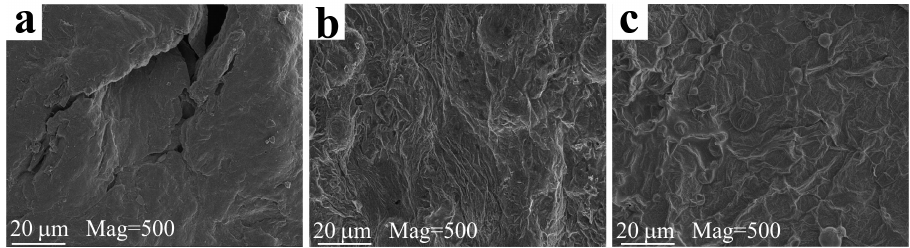
Figure 8. SEM images of the char residue obtained after CCT for PP1 ( a ), PP3 ( b ), PP6 ( c ). The quality of char residues after CCT was further characterized via Raman spectros- copy, as depicted in Figure 9. Two sharp peaks at 1377 cm − 1 and 1600 cm − 1 are attributed to the D and G bands, representing the graphitic structure and lattice defect of carbon atom, respectively. Generally, the area ratio (A D /A G ) of D and G bands reveals the graph- itization degree of the char residue, and a lower A D /A G value means a higher graphitiza- tion degree and better quality of the char layer [49]. The calculated A D /A G values are in descending order of PP1 (2.83) > PP3 (2.69) > PP6 (2.54), which indicates that the combi- nation of APP and HP-Mn can improve synergistically the quality of char residue as com- pared with the incorporation of APP or HP-Mn alone, which facilitates the formation of much denser and continuous char layers with high strength. The flame retardancy, con- sequently, is improved with the combined incorporation of APP and HP-Mn.